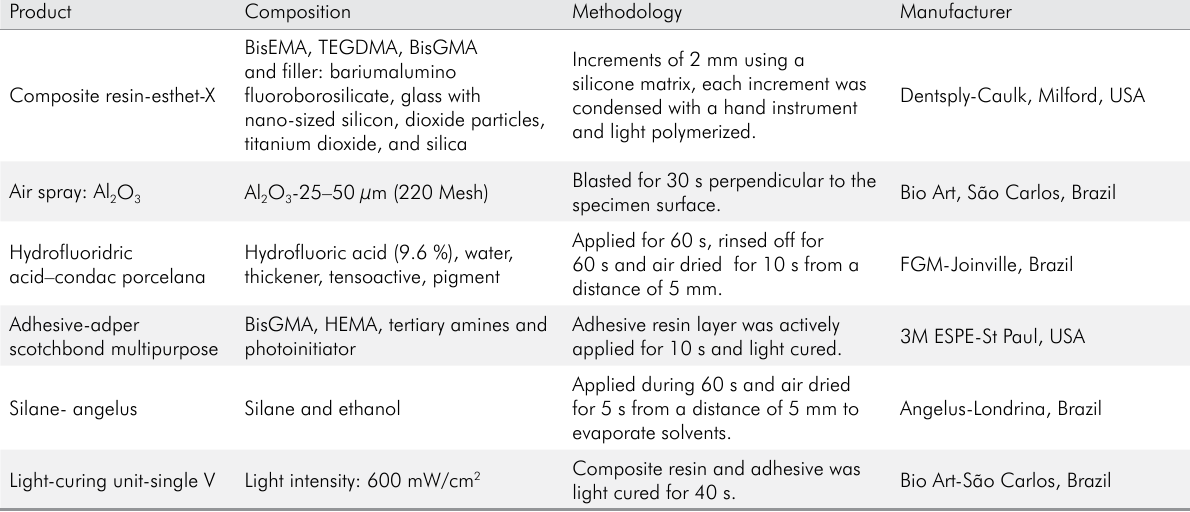
Table 1. Materials used in the